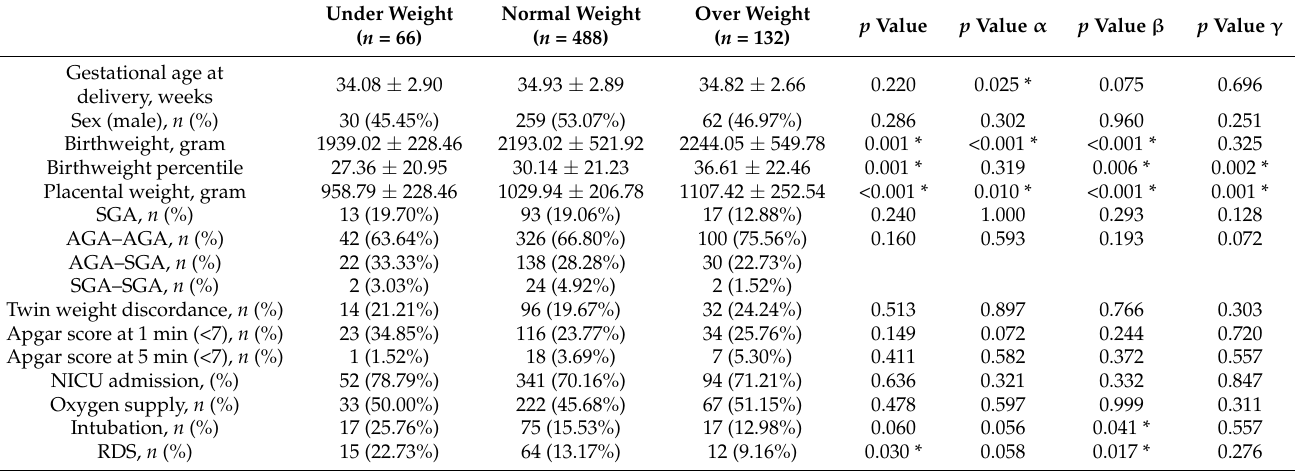
Table 2. The neonatal outcomes according to maternal pre-pregnant BMI in twin pregnancy. Under Weight Normal Weight Over Weight ( n = 66) ( n = 488) ( n = 132)